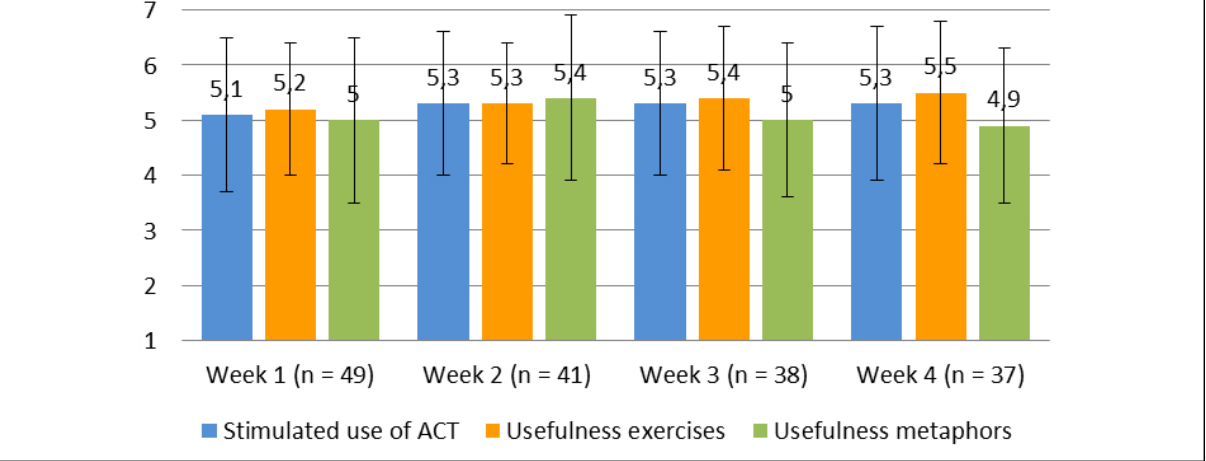
Figure 5. User experience of the ACT in Daily Life Training (ACT-DL).